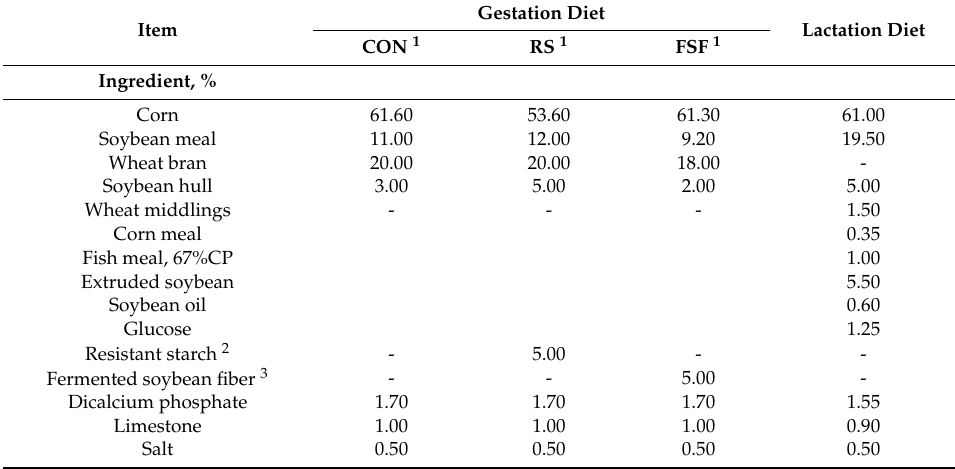
Table 1. Ingredients and nutrient composition of experimental gestation diets and lactation diets (as-fed